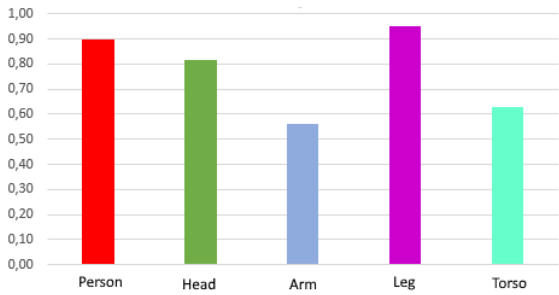
Figure 12. Average class precision for YOLOv3. Source: